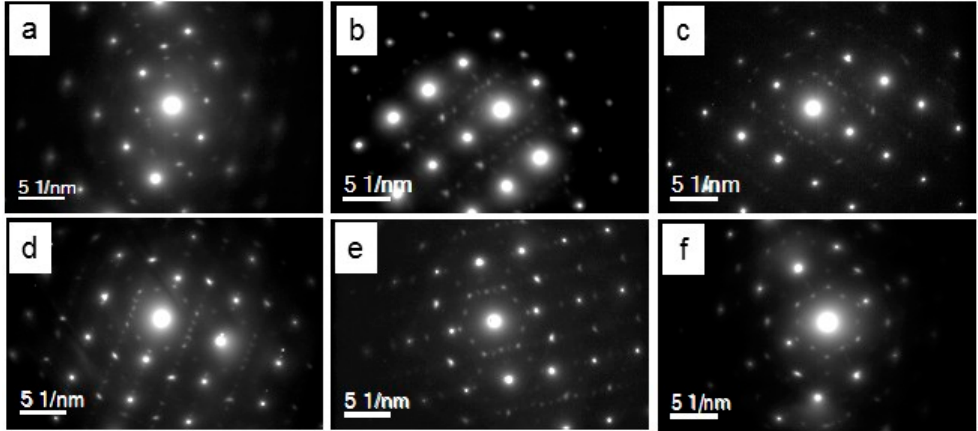
Figure 6. TEM diffraction patterns used to determine the type of precipitates in the <15 nm size range: ( a ) HFT/600/15, ( b ) HFT/650/15, ( c ) LFT/600/15, ( d ) HFT/600/30, ( e ) HFT/650/30, ( f ) LFT/600/30.